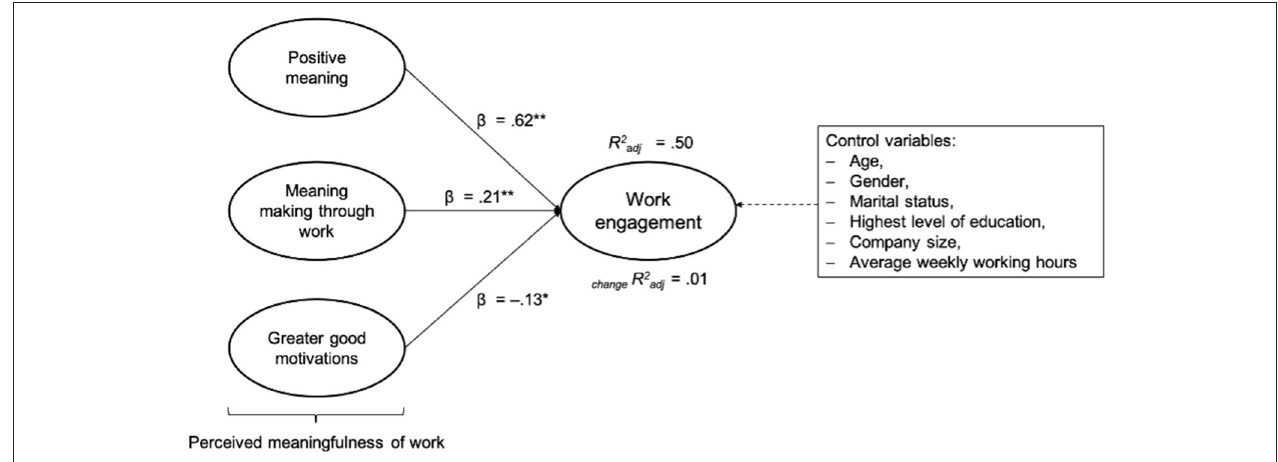
FIGURE 2 | Multiple regression analysis with the total work engagement score as a dependent variable and PM, MM, and GG as independent variables (step 1);